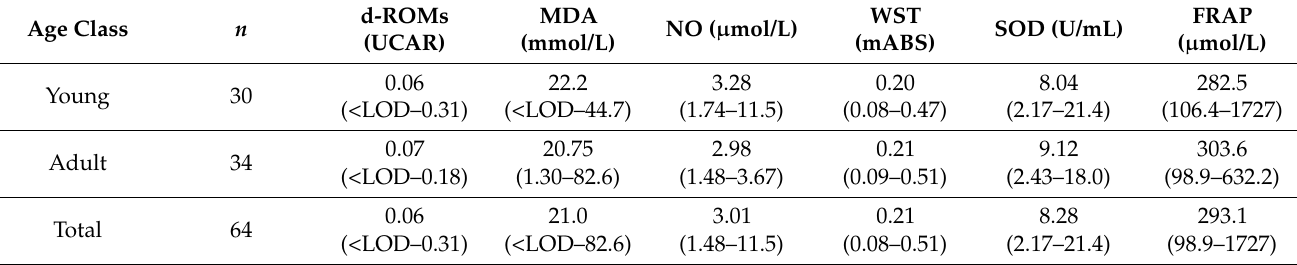
Table 3. Biomarkers of oxidative stress (OS) in blood of Eurasian magpies according to age-class. d-ROMs: determinable reactive oxygen species; MDA: malondialdehyde; NO: nitric oxide; WST: water soluble tetrazolium; SOD: superoxide dismutase; FRAP: ferric reducing antioxidant power. All data are expressed as median and range. LOD = limit of detection. Age